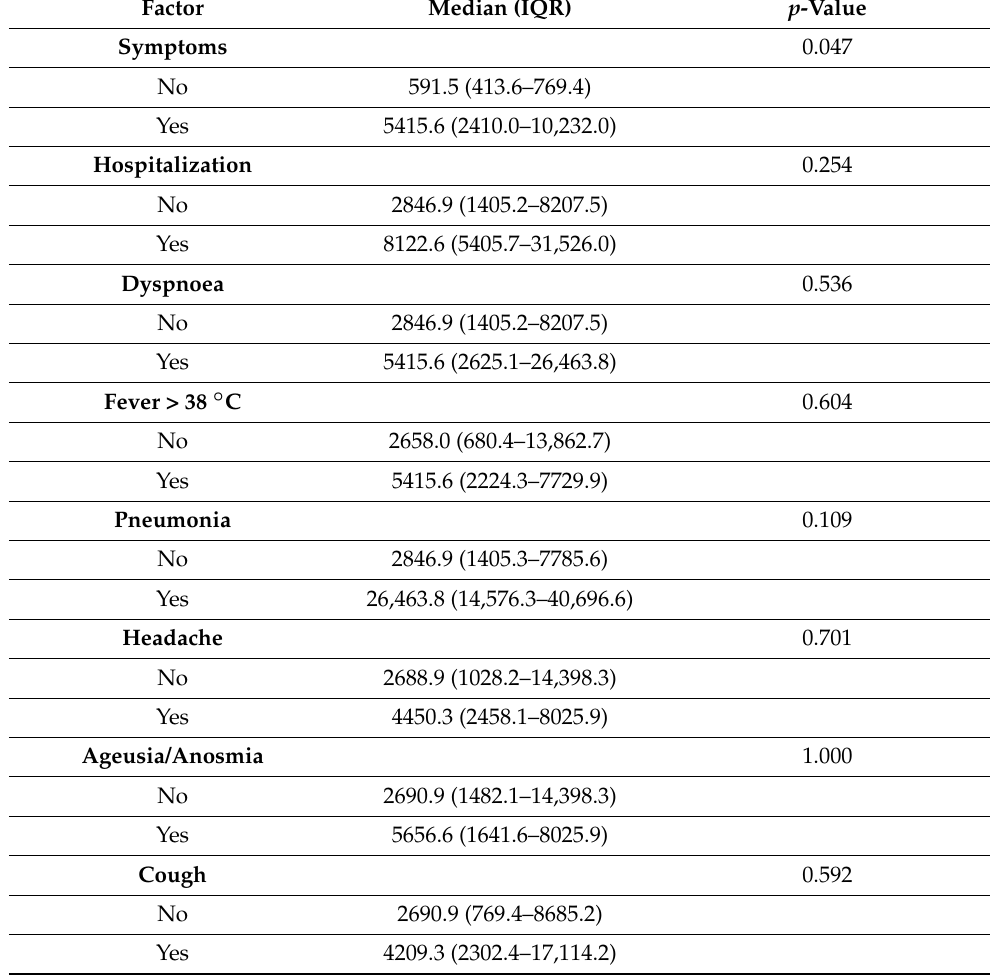
Table 3. Comparison between “anti SARS-CoV-2 antibody titer”, expressed in UA/mL and several symptoms among the SARS-CoV-2 positive individuals.